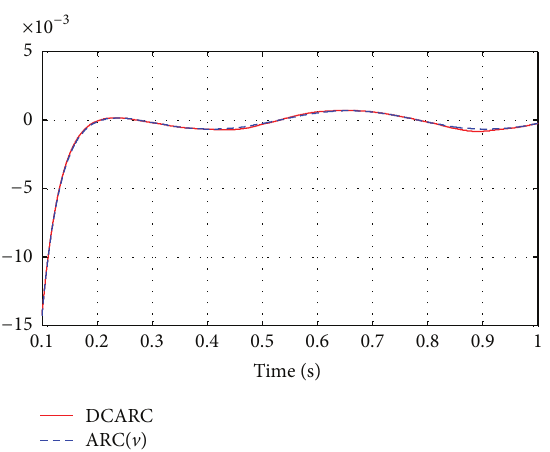
Figure 7: Scaled ARCs’ tracking errors for a fast sinusoidal curve in the presence of parametric uncertainties and uncertain nonlineari- ties.